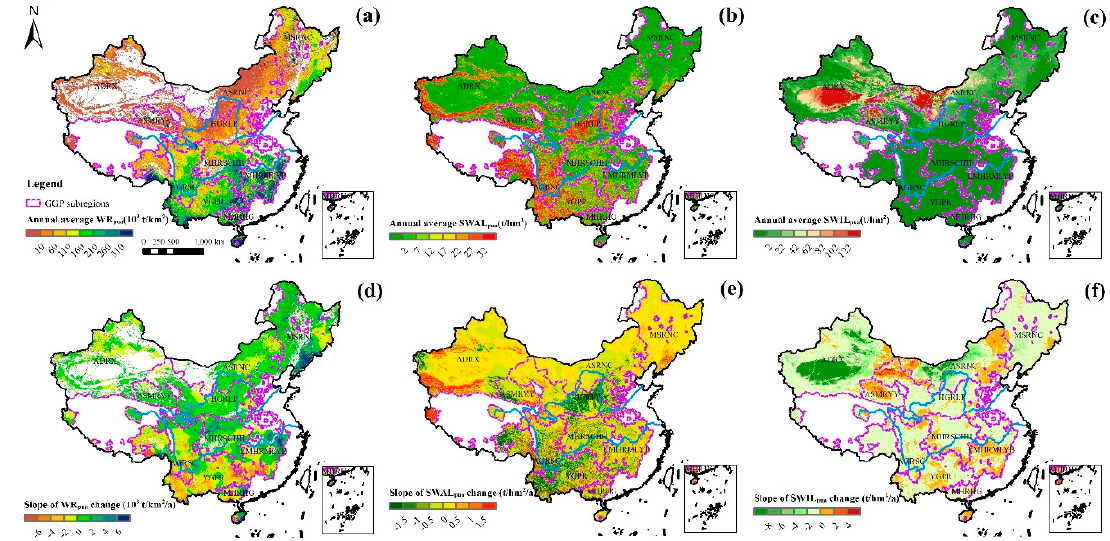
Figure 6. Spatial pattern of annual average ecosystem services (ESs) and slope of ESs change in the Grain for Green Program (GGP) area from 2000–2010. ( a – c ) are the annual average WR pua , SWAL pua , and SWIL pua , respectively; ( d – f ) refer to the slope of annual WR pua , SWAL pua , and SWIL pua changes, respectively.